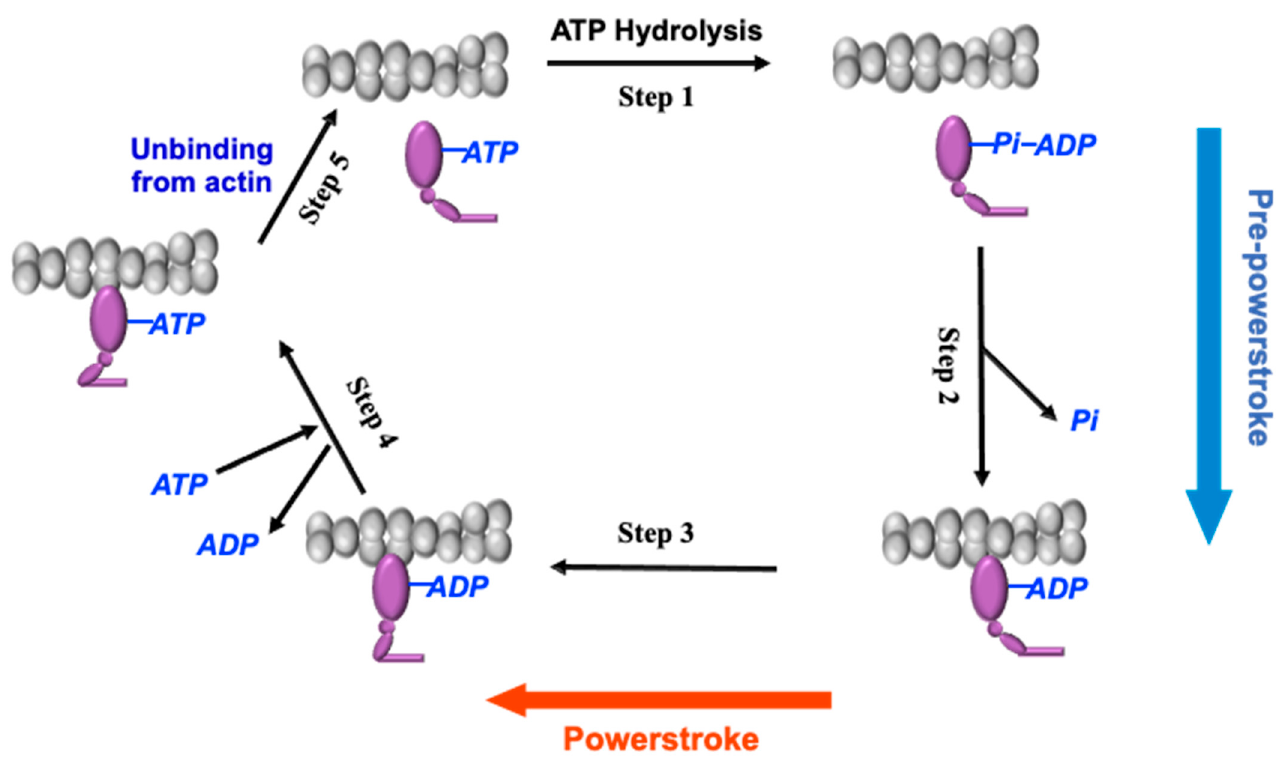
Figure 3. (Panel A ): A schematic of two myosin conformations and associated energy consumption throughout the cardiac cycle: A pair of myosin molecules is depicted, with each head denoted as blocked (BH) or free (FH). The disordered relaxed state (DRX) insulates the BH, resulting in inhibition of ATPase (denoted by a blue dot), while FH retains adenosine triphosphate (ATP) hydrolysis activity and triggers actomyosin function modulating by myosin binding protein C (MyBPC). The super-relaxed state (SRX) insulates both BH and FH, and energy conservation is maximized because both myosin ATPase domains are inhibited. Hypertrophic cardiomyopathy variants preferentially shift conformation toward the DRX, resulting in hypercontractility, impaired relaxation, and excessive energy consumption. Mavacamten can stabilize the SRX state, attenuate hypercontractility, and improve compliance in cardiomyocytes. (Panel B ): Biochemical cycle of cardiac myosin. During diastole, one head of myosin hydrolyzes ATP to adenosine diphosphate (ADP) and inorganic phosphate (Pi) (Step 1). Actin becomes accessible, and the head of myosin binds to it and forms the “pre-powerstroke” state. During systole, a subset of myosin heads in the pre-powerstroke promotes the release of Pi (Step 2), which initiates the “powerstroke” to generate force, shortening the sarcomere. (Step 3). The loss of ADP and another binding of ATP (Step 4) releases the myosin from the actin filament because myosin-ATP has a low affinity for actin (Step 5). Omecamtiv mecarbil increases the rate of Pi release (Step 2) and bias the ATP hydrolysis step (Step 1) toward pre-powerstroke state, enabling more myosin heads to undergo a powerstroke during systole.